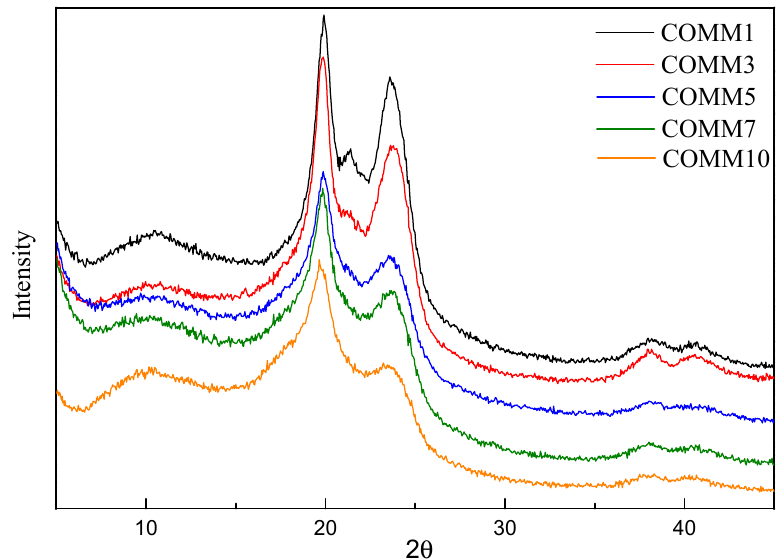
Figure 12. X-ray diffraction spectrum for PA6 containing dimer oleic acid and 4,4'-Methylenebis(2- methylcyclohexylamine)